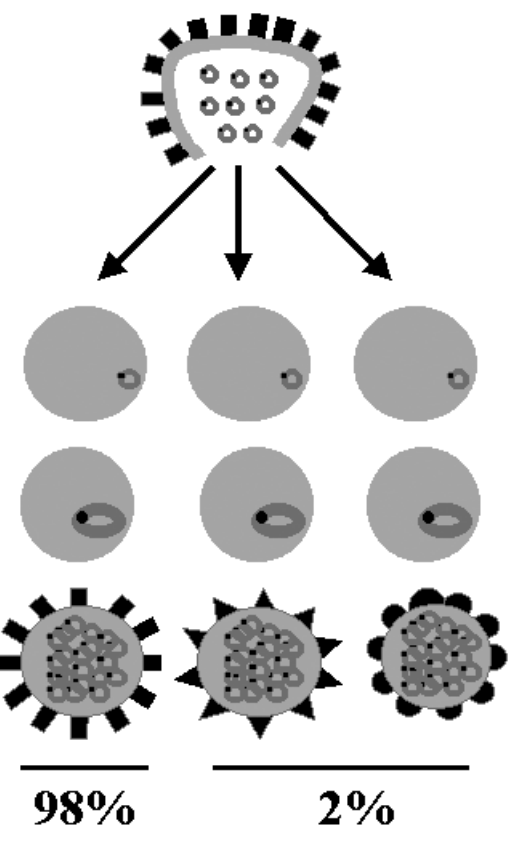
Fig. 3 – Schematic representation of PfEMP1 protein switch- ing. Merozoites released from a burst infected red blood cell ex- pressing a particular PfEMP1 phenotype (squares), invade new erythrocytes which after completion of the asexual blood cycle give rise to schizonts expressing the original PfEMP1 phenotype in 98% of the erythrocytic population; remaining erythrocytes express different phenotypes at a rate of 2% (Biggs et al. 1991, Roberts et al.